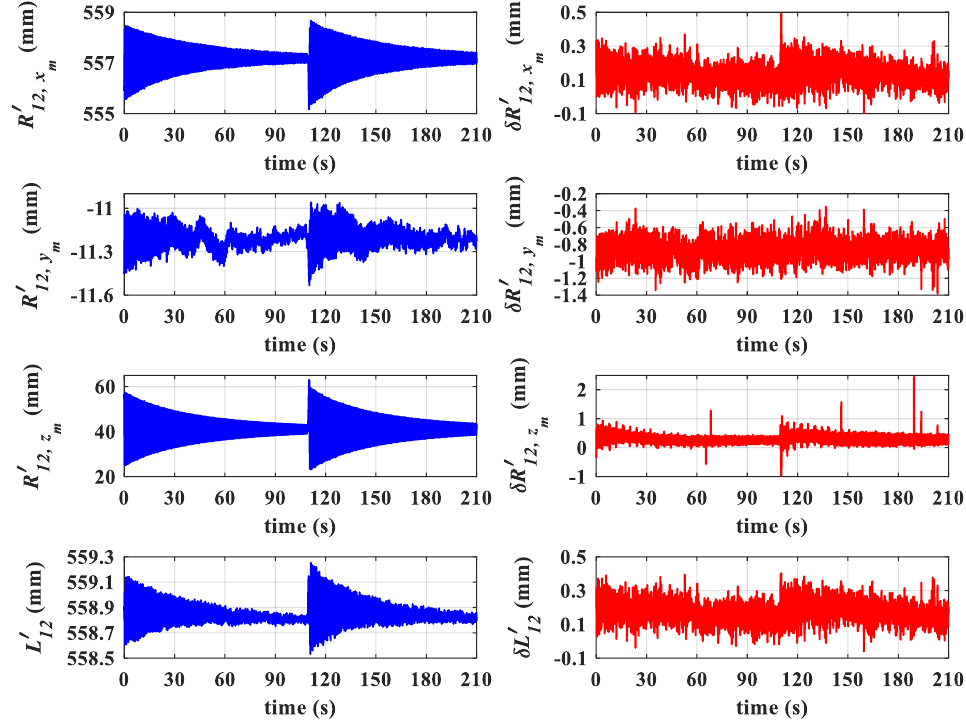
Figure 10. Measured values and errors of relative position and baseline length between antennas 1 and 2.